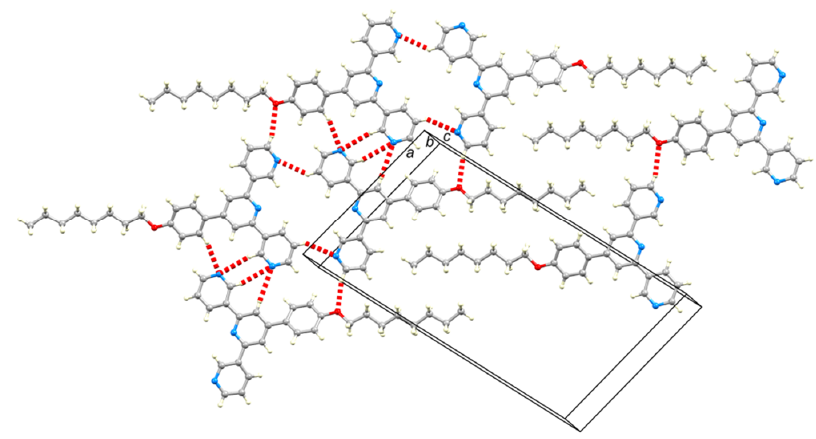
Figure 8. Within each layer of molecules of 8 , van der Waals interactions between n -alkyloxy chains, and C–H...N and C–H...O weak hydrogen bonds (red hashed lines) are important packing interactions. See Figure S15 for a space-filling representation.